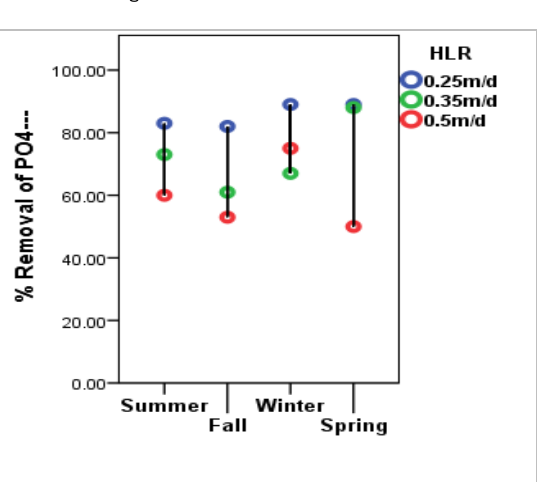
Figure 10. Trend of P0 43- removal